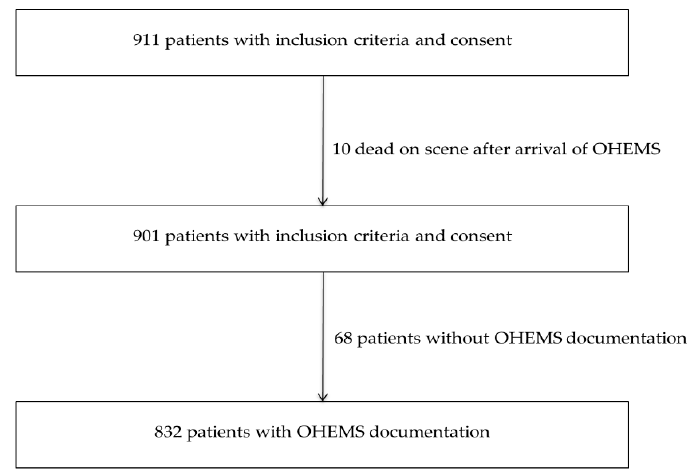
Figure 1. Flowchart of included patients with severe traumatic brain injury.